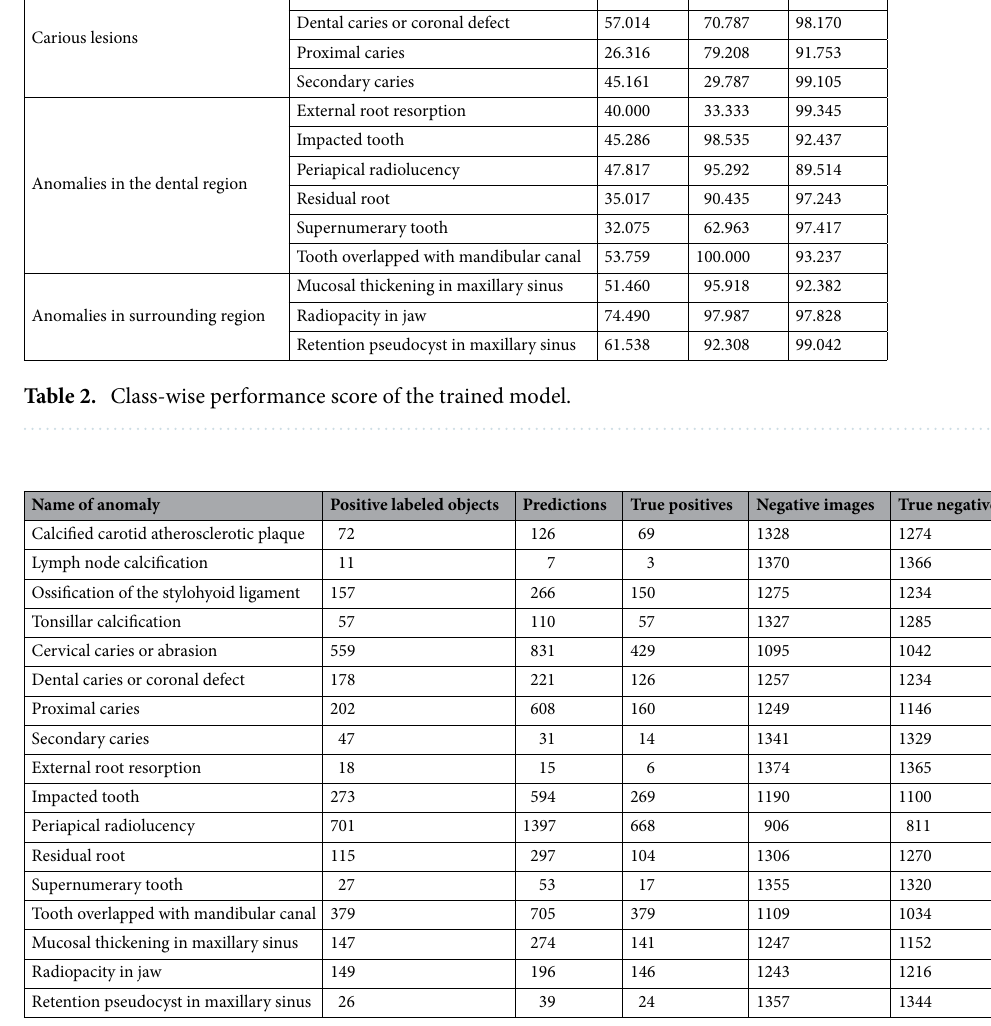
Table 3. Class-wise performance score of the trained model.